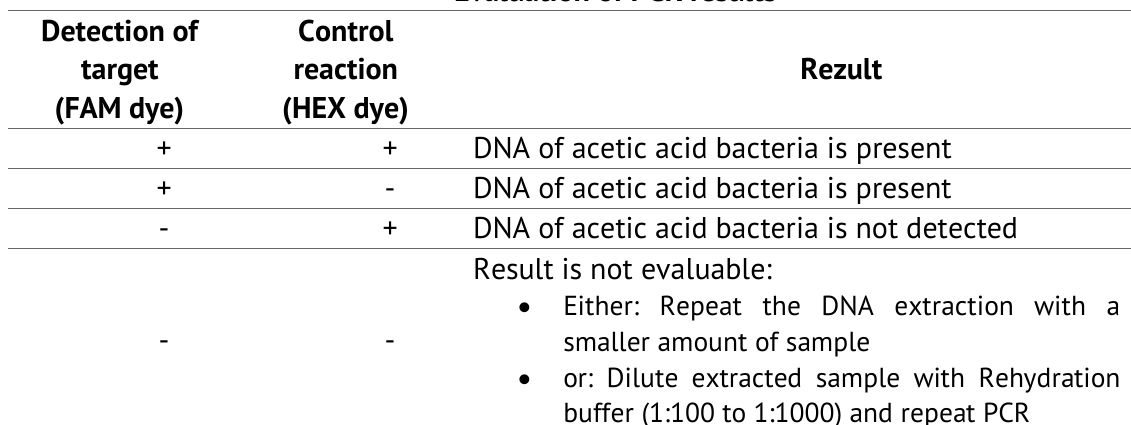
Evaluation of PCR results